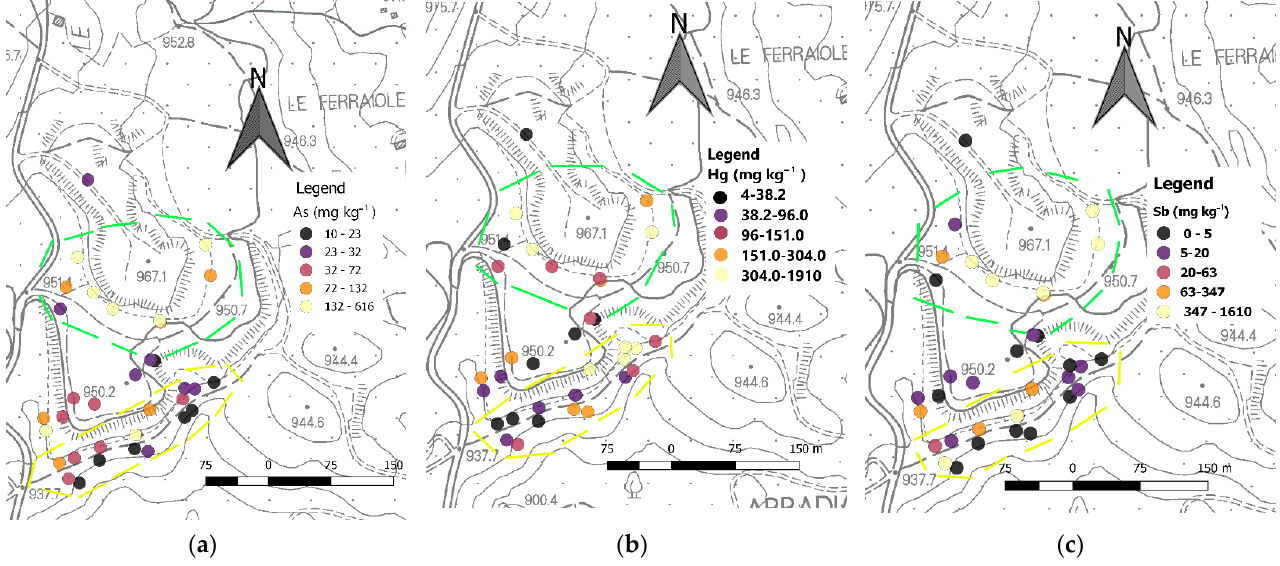
Figure 5. The dots maps of the studied topsoils of As ( a ), Hg ( b ) and Sb ( c ). The yellow and pale-green dashed lines are probably defining the areas where the post-roasting processes by the Gould and Cermak-Spirek furnace were located, respectively.